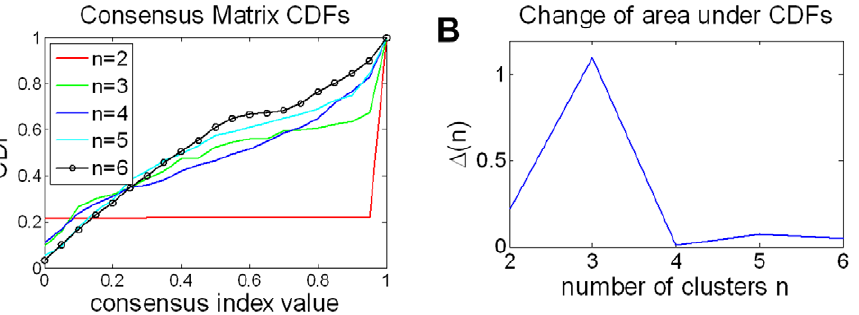
Figure 3. The CDF and its derivative, computed from the consensus matrix, is used to identify the number of clusters. (A) CDF for each cluster, and (B) change in CDF as a function of cluster size, indicates that three is the optimum number of sub-populations.